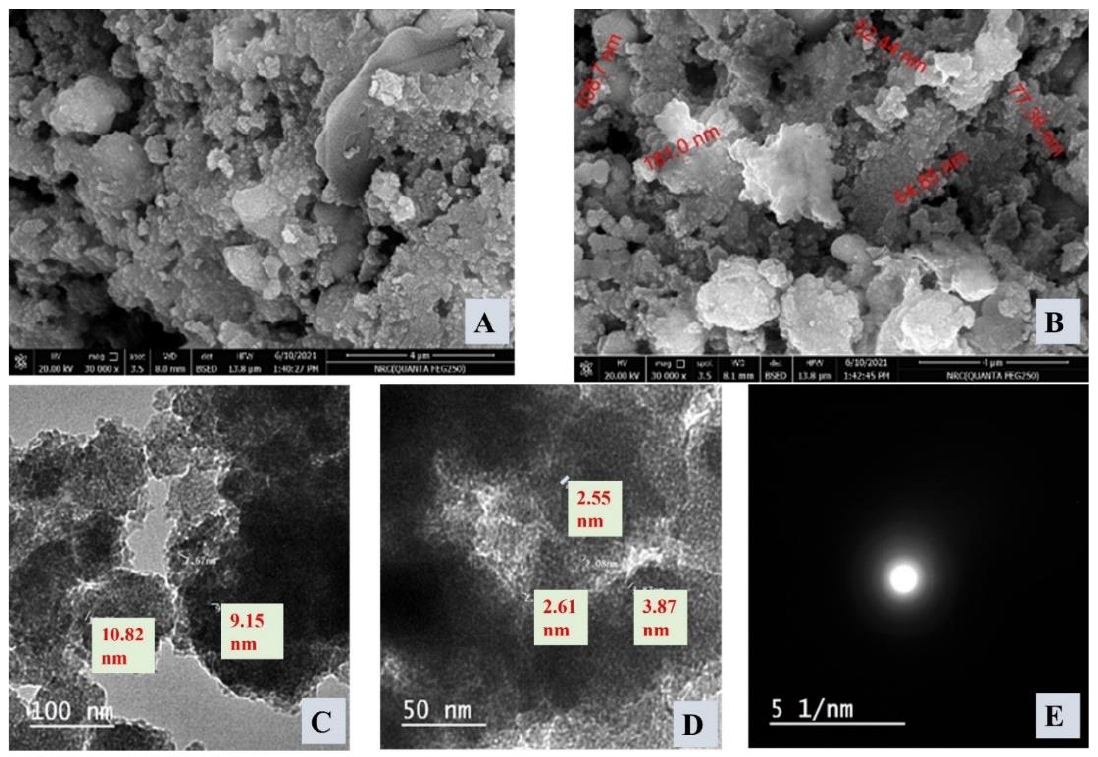
Figure 1. ( A ) SEM image of ZnTiO@PANi nanocomposite, ( B ) SEM image of ZnTiO@PANi nanocomposite in another investigation area, ( C ) TEM of ZnTiO@PANi nanocomposite, ( D ) HR-TEM of ZnTiO@PANi nanocomposite at higher magnification, and ( E ) SAED of ZnTiO@PANi nanocomposite.